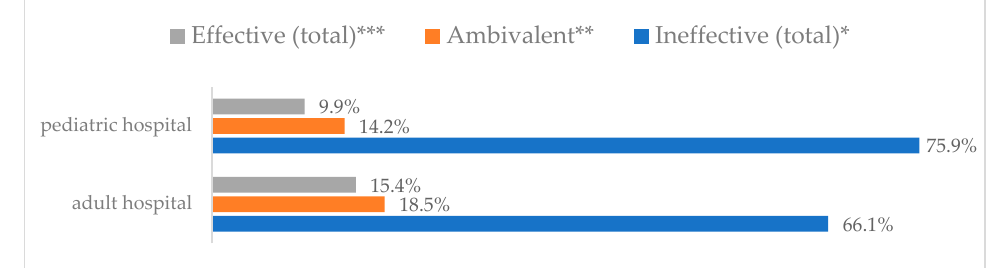
Figure 27. Taking preparations with inosine to prevent influenza virus infection by age ( N = 905). *Sum of responses: completely ineffective, ineffective, rather ineffective; **Response: neither inef- fective nor effective; ***Sum of responses: rather effective, effective, completely effective.